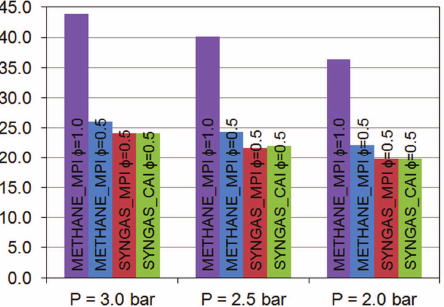
Fig. 15. Results of power for final operating points